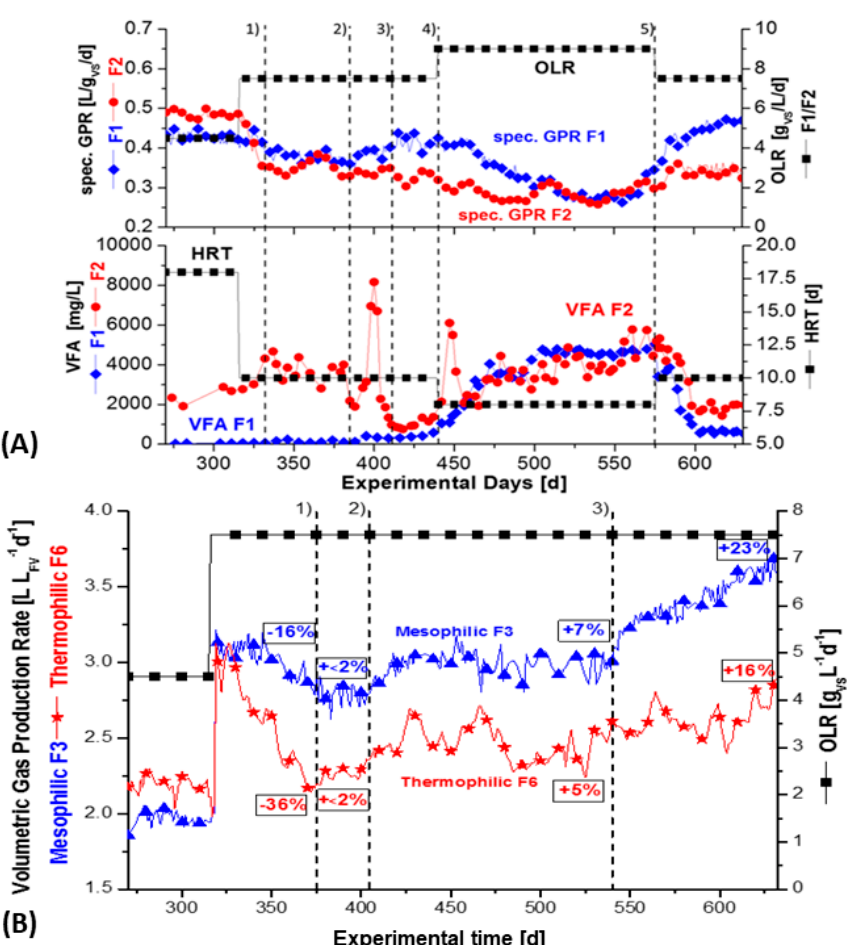
Figure 4. ( A ) Specific biogas production (L STP ) per gram VS wheat straw of fermenter F1 and